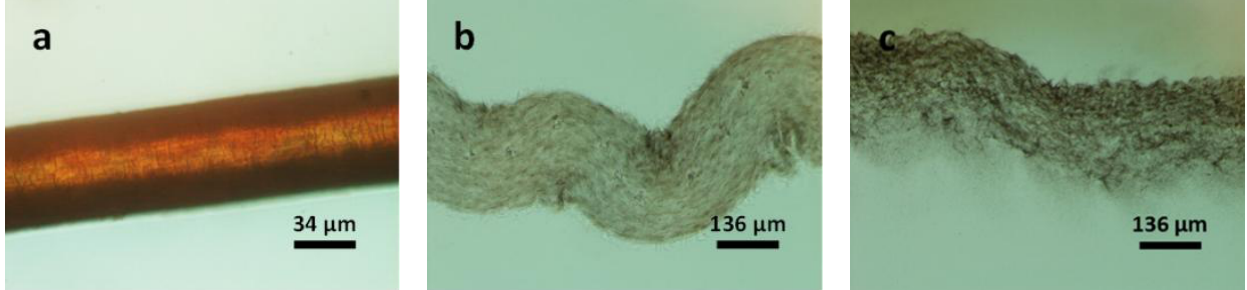
Figure 3. POM images of a black hair fibre in [Bmim]OAc at 120 °C: ( a ) original fibre; for ( b ) 25 min; and ( c ) 90